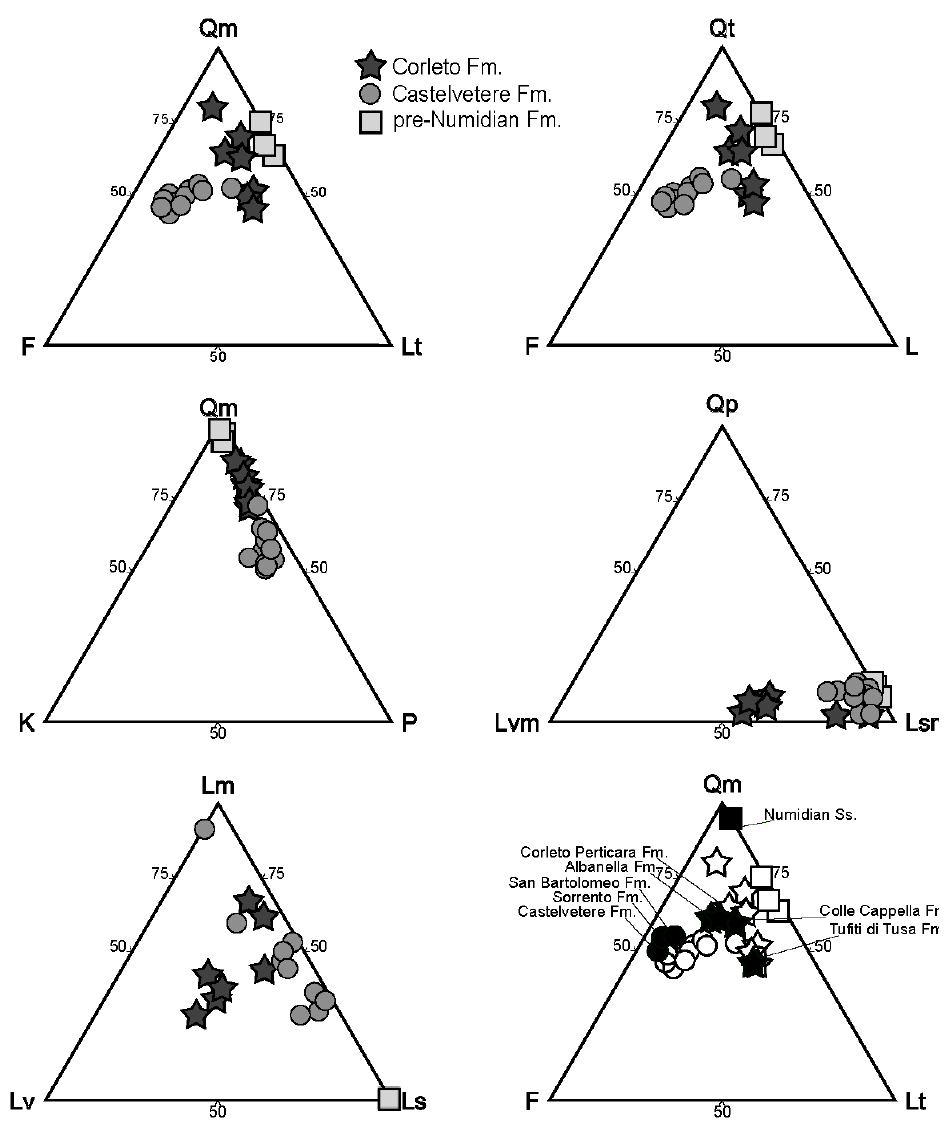
Figure 11. Ternary compositional plots of the Corleto / Albanella, Castelvetere, and pre-Numidian sandstones and their relations with similar sandstone suites of the southern Apennines foreland basin system. Qm, monocrystalline quartz; Qp, polycrystalline quartz, Qt, (Qm + Qp), F, feldspars (K + P); K, K-feldspar; P, plagioclase; Lt, aphanitic lithic fragments; Lm, aphanitic metamorphic lithic fragments; Lv and Lvm, aphanitic volcanic (Lv) and metavolcanic (Lvm) lithic fragments; Ls, aphanitic sedimentary lithic fragments, Lsm, metasedimentary and sedimentary lithic fragments. Latter ternary compositional plot Qm-F-L documents the relations of the Corleto, Castelvetere, and pre-Numidian sandstones and with related sandstone suites of the southern Apennines foreland basin system (Regional dataset of the southern Apennines foreland sandstone suites is in Table 5).